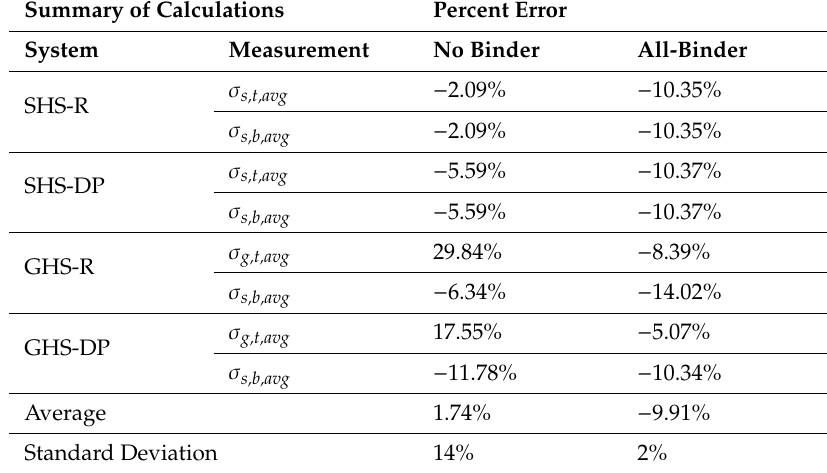
Table 5. A select subset of Table 4 in which the di ff erences in reinforcement stress can be better comprehended for comparison